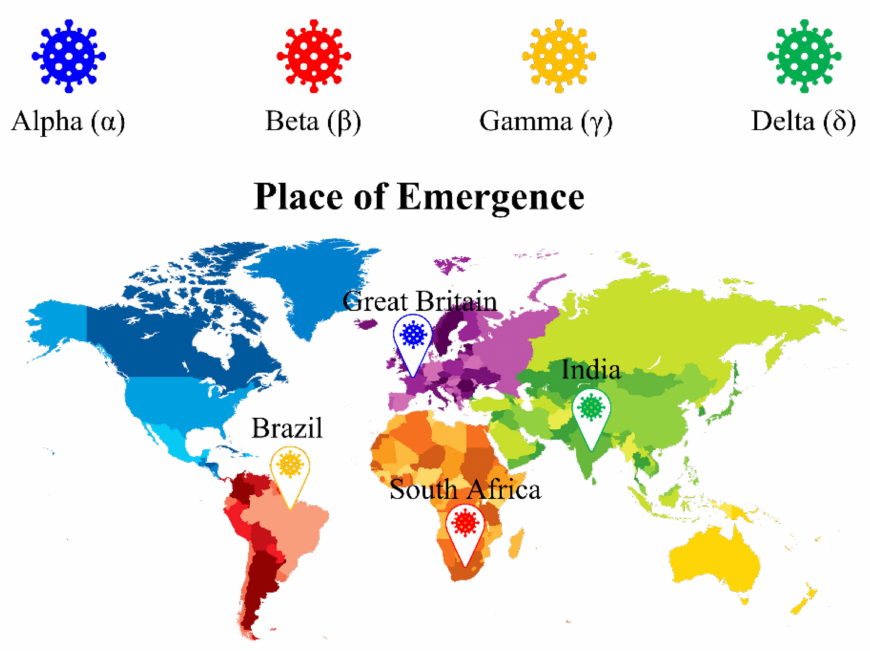
Figure 1. Variants of concern and their